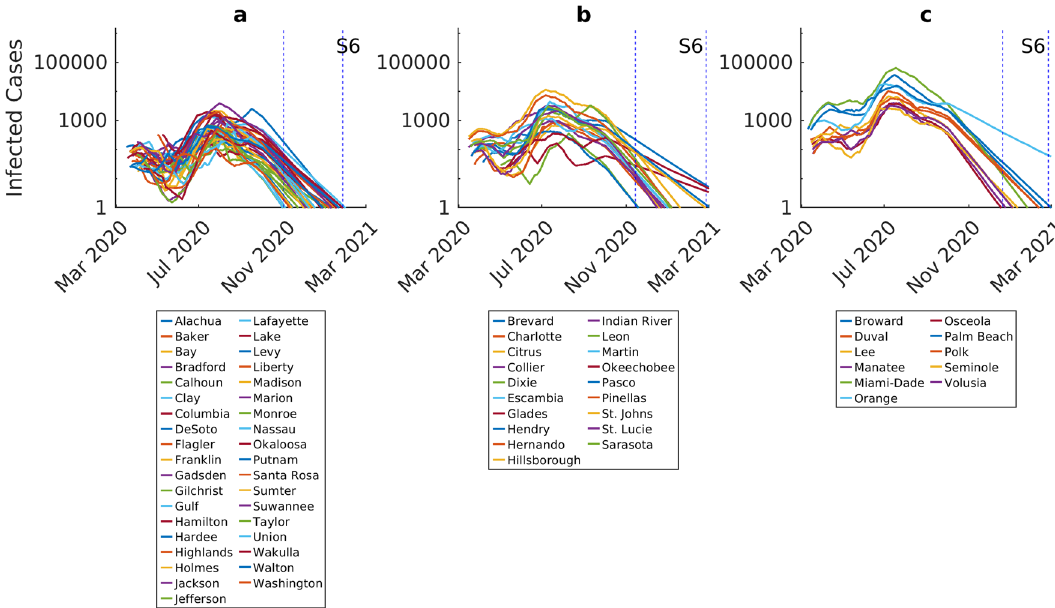
Figure 5. Epidemic forecasts for individual counties in the scenario where all interventions (movement restriction, social distancing, and contact tracing) are held through to March 2021 starting from October 1st 2020. Each curve represents the median prediction for a given county. The results are stratified by initial incidence growth rate (Group a < 0.05, Group b > 0.05–0.15, Group c > 0.15). The y-axis is shown in log-scale to better visualize the difference between the size of the first and second epidemic waves. Red vertical lines indicate the ranges of peak infected cases, while blue vertical lines indicate the typical ending times of the epidemic. The ending dates for the epidemic are predicted to occur between November 1st–January 26th 2021 for Group a, November 14th–February 25th 2021 for Group b, and December 20th–February 25th 2021 for Group